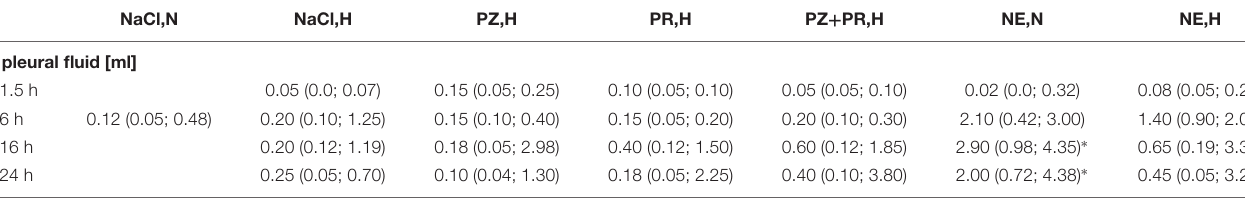
TABLE 3 | Effects of hypoxia and/or adrenergic and antiadrenergic treatment on the amount of pleural fluid.